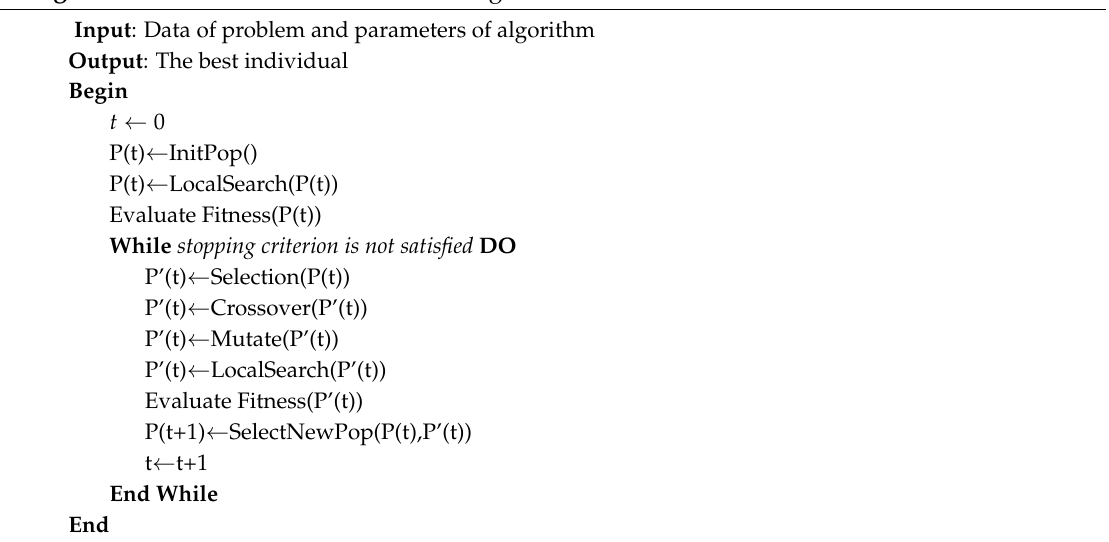
Algorithm 1: Structure of the Memetic